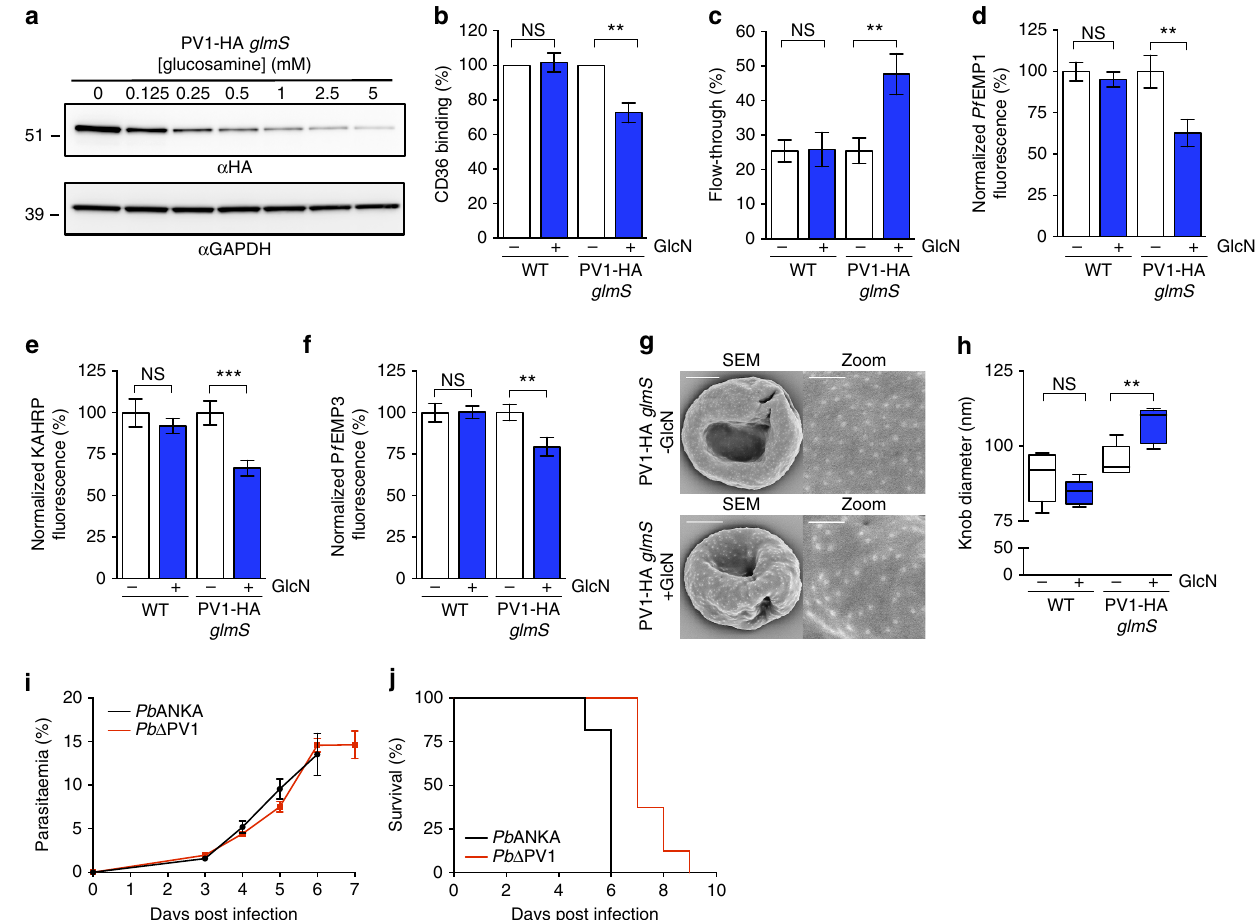
Figure 7 | Genetic attenuation of PV1 affects virulence determinants in P. falciparum and P. berghei . ( a ) PV1-HA glmS parasite-infected RBCs treated with increasing concentrations of glucosamine (GlcN) from the trophozoite stage of the previous cycle. Western blots (anti-HA) confirm knockdown of expression of PV1-HA. Molecular masses are shown in kDa. Uncropped western blots are shown in Supplementary Fig. 12. ( b ) Adherence of wild-type (WT) or PV1-HA glmS- infected RBCs (23–26 or 30–34h post invasion (h.p.i.)) to recombinant CD36 under flow conditions (0.1Pa) ± s.e.m. measured in 10 predetermined fields (binding indicates % of nontreated control, n ¼ 5, ** P ¼ 0.006 unpaired t -test, NS, not significant). ( c ) Passage of WT or PV1-HA glmS- infected RBCs (23–26 h.p.i.) through microbeads ± s.e.m. (filterability compares parasitaemia pre- and post-filtration, n ¼ 6, ** P ¼ 0.01 unpaired t - test). ( d – f ) Intensity of Pf EMP1, KAHRP and Pf EMP3 immunofluorescence signals ± s.e.m. in WTor PV1-HA glmS- infected RBCs (23–26 h.p.i.), normalized relative to the signal from the cytoplasmic protein, Pf GAPDH ( Pf EMP1: n Z 15 cells, ** P ¼ 0.0064 unpaired t -test; KAHRP: n Z 56 cells, *** P o 0.001 unpaired t -test; Pf EMP3: n Z 26 cells, ** P ¼ 0.009 unpaired t -test). ( g , h ) Scanning electron microscopy (SEM) of WT or PV1-HA glmS- infected RBCs. ( g ) Representative SEM micrographs of knobs from PV1-HA glmS -infected RBCs in the presence and absence of 2.5mM GlcN. Scale bars,3 m m. Zoom scale bars, 500nm. ( h ) Quantification of knob size represented by box-and-whisker plot showing median and interquartile range ( n ¼ 6 cells, ** P ¼ 0.003 unpaired t -test, whiskers represent minimum/maximum measurements). ( i ) Parasitaemia and ( j ) survival curves of C57/BL6 mice (mean ± s.e.m., n ¼ 11 Pb ANKA, n ¼ 10 Pb D PV1) after intraperitoneal administration of 1 (cid:2) 10 6 Pb ANKA or Pb D PV1 parasites. ( i ) No significant difference in parasitaemia for Pb ANKA and Pb D PV1 parasites was observed ( P ¼ 0.63, unpaired t -test). ( j ) Survival of Pb D PV1-infected mice was increased in comparison with Pb